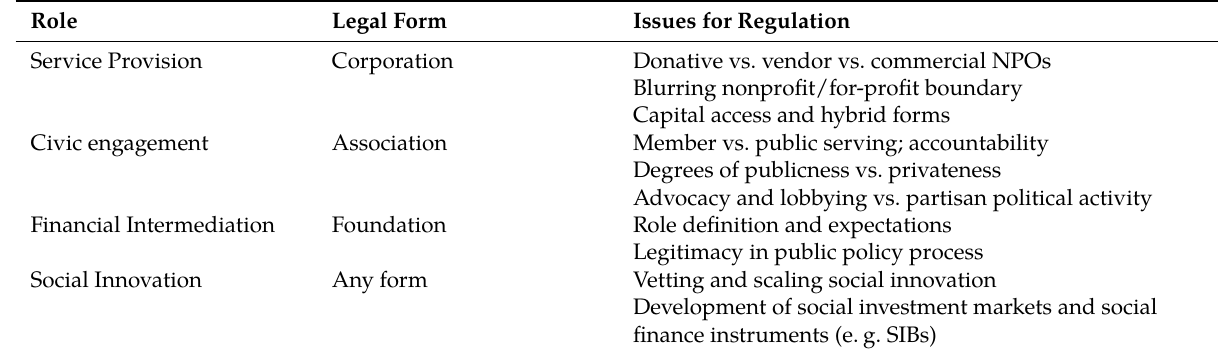
Table 1: Nonprofit roles, predominant legal forms, and related regulatory